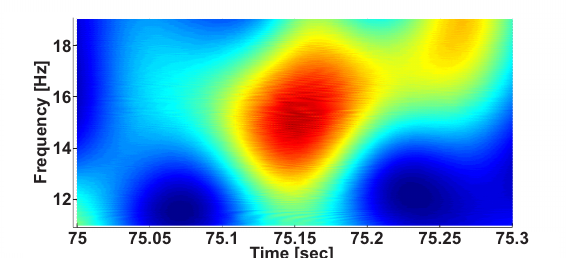
Figure 3. A wave train on the wavelet spectrogram of the EMG signal envelope. The abscissa axis indicates the time; the ordinate axis indicates the frequency.